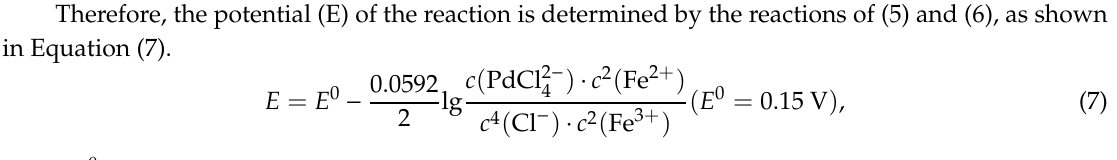
Figure 3. The relationship between the molar ratio of Fe 3+ /Fe 2+ and the necessary concentration of chloride for oxidation of Pd to PdCl 42 − .